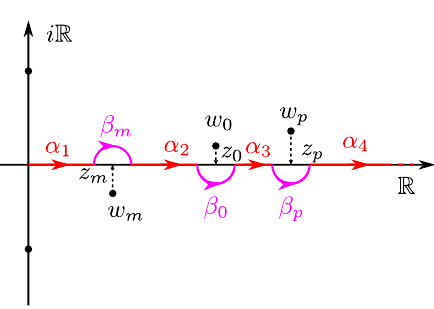
Figure 13 . Contour used to compute the (cid:12)nite temperature part. Black dots: poles of the function G (cid:27) 1 (cid:27) 2